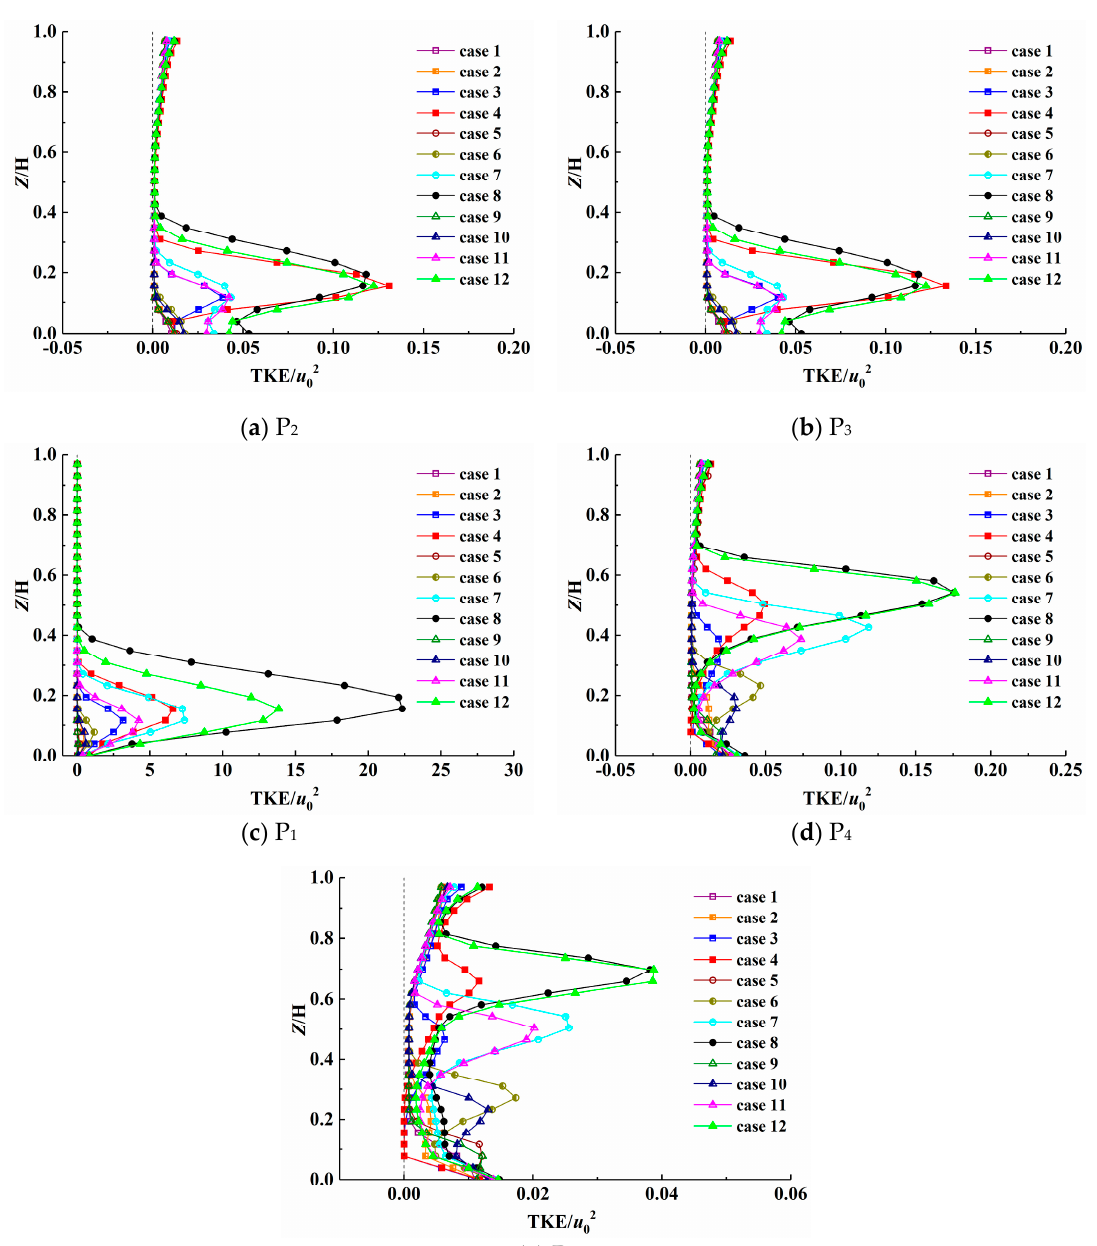
Figure 8. Distribution of the turbulent kinetic energy ( TKE ) values at different locations along the water depth: ( a ) P 2 , ( b ) P 3 , ( c ) P 1 , ( d ) P 4 , ( e ) P 5 .